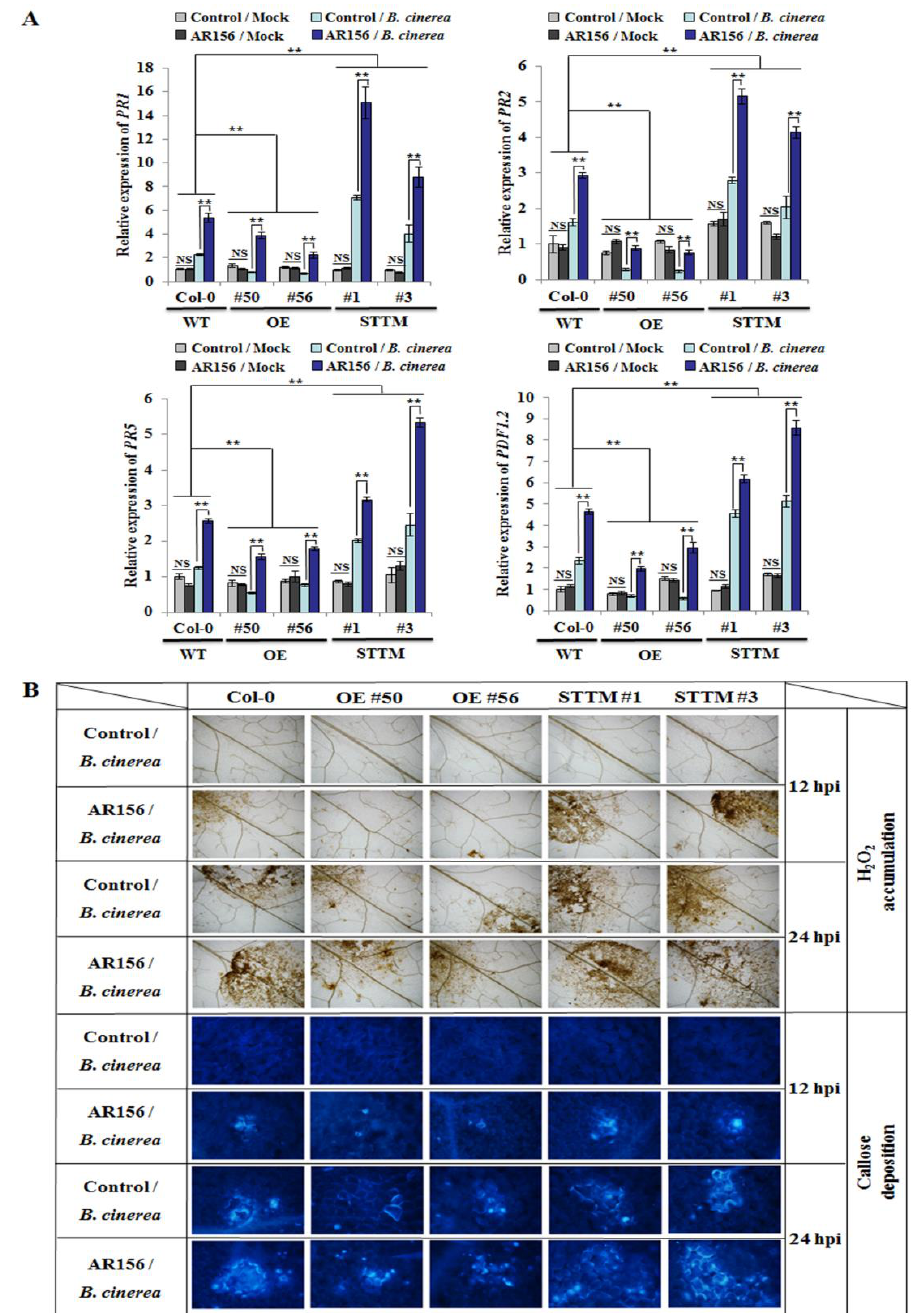
Figure 3. The defense gene expression and cellular defense responses in different genotypes.Roots of three-week-old plants from Col-0, miR825/825* OE lines (#50 and #56), and STTM825/825* lines (#1 and #3) were drenched with AR156 at 5 × 10 8 CFU/mL or 0.85% NaCl (control). After 7 days, the leaves of these plants were inoculated with a B. cinerea B1301 spore suspension (1 × 10 6 spores/mL) or H 2 O (mock), which were collected at 12, 24, and 48 hpi. ( A ) Transcription of defense-related genes upon attack by B. cinerea B1301. Using qRT-PCR, transcriptional levels of defense genes in leaves collected at 48 hpi were examined and normalized with those of AtActin1 . The data are presented as mean ± SD from three biological replicates. The assay was repeated three times, yielding similar results. Two-way ANOVA showed significant effects of genotype on the expression of PR1 , PR2, PR5 , or PDF1.2 ( P < 0.01 for the differences between WT and OE, and also for those between WT and STTM); and a significant treatment effect ( P < 0.01) and a significant interactive effect ( P < 0.01) on the expression of each tested gene. Note: NS, not significant; ** P < 0.01. ( B ) Hydrogen peroxide accumulation and